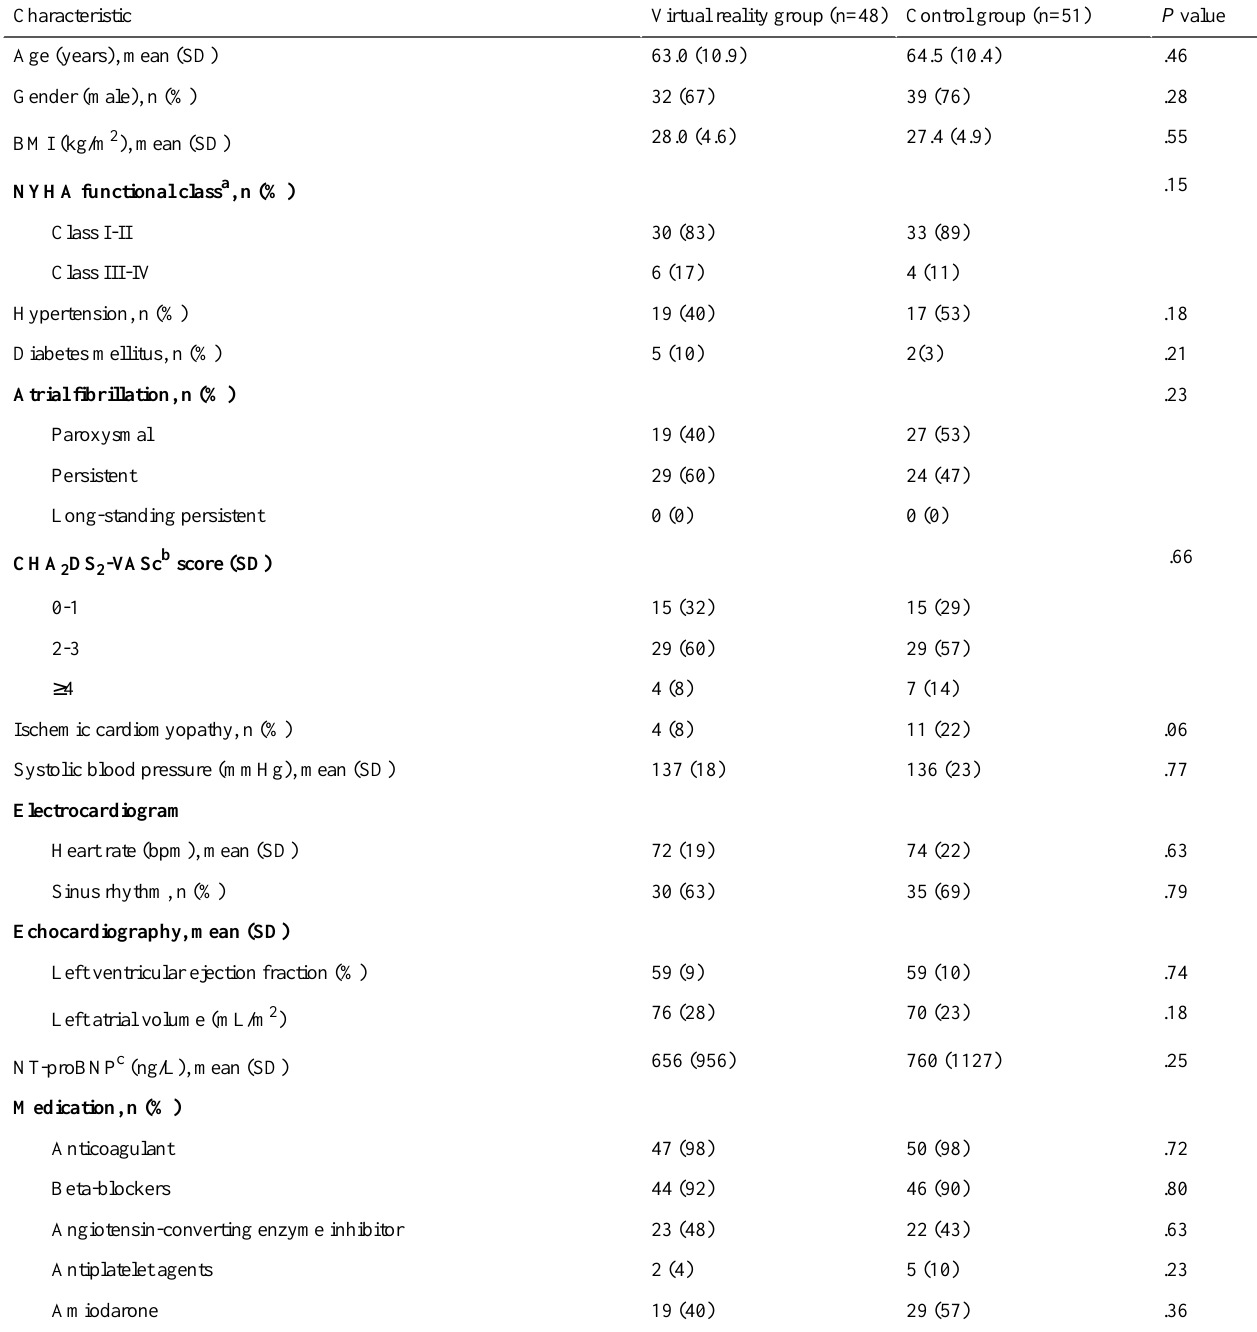
Table 1. Baseline